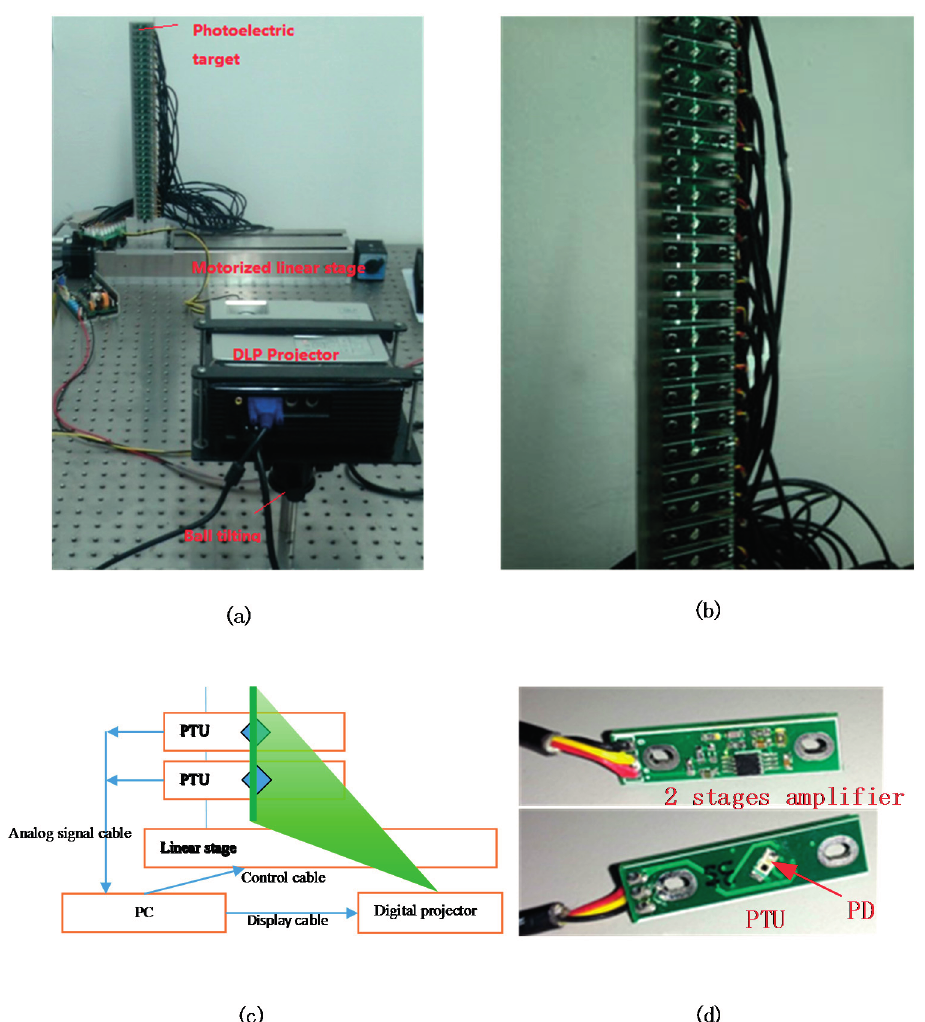
Figure 4. Experiment setup of the calibration system. ( a ) Relative positions of the DLP projector, the photoelectric target and the motorized stage; ( b ) The photoelectric target with the projected line pattern; ( c ) Schematics of the entire projector calibrating system (Only two PTUs are shown) and ( d ) the enlarged view of the photoelectric